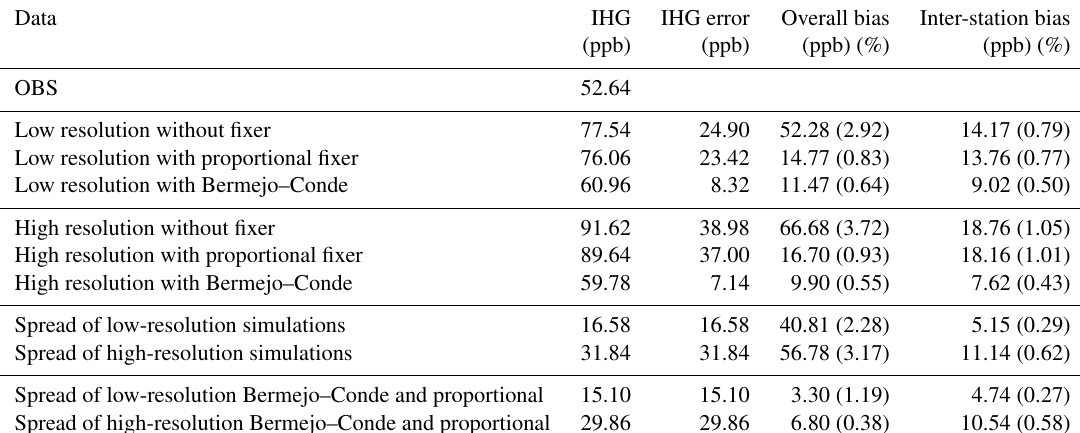
Table 6. XCH 4 inter-hemispheric gradient (IHG) error (MODEL − OBS) statistics for simulations with different resolution and different mass fixers with respect to observations from TCCON.